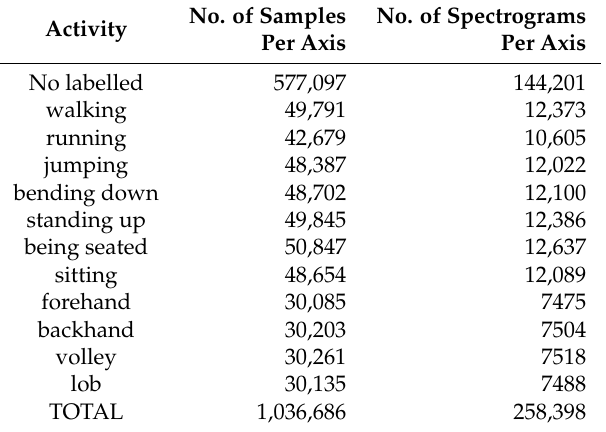
Table 2. Number of samples for each sensor axis in the